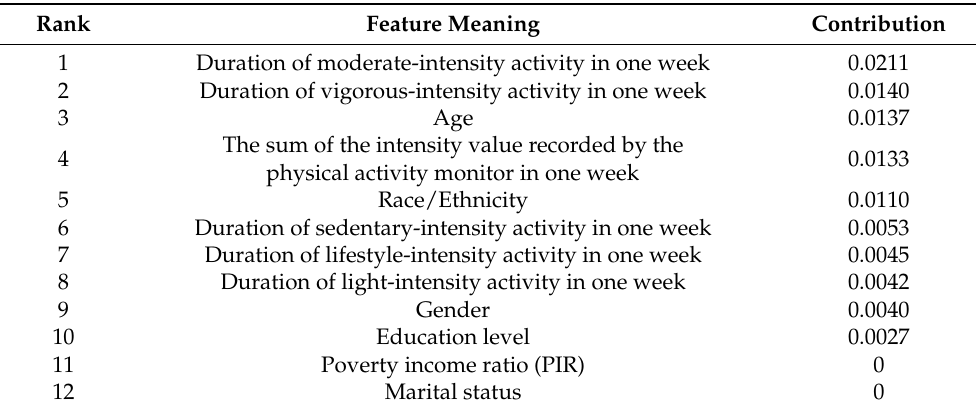
Table 4. Ranked feature importance in predicting weight status based on information